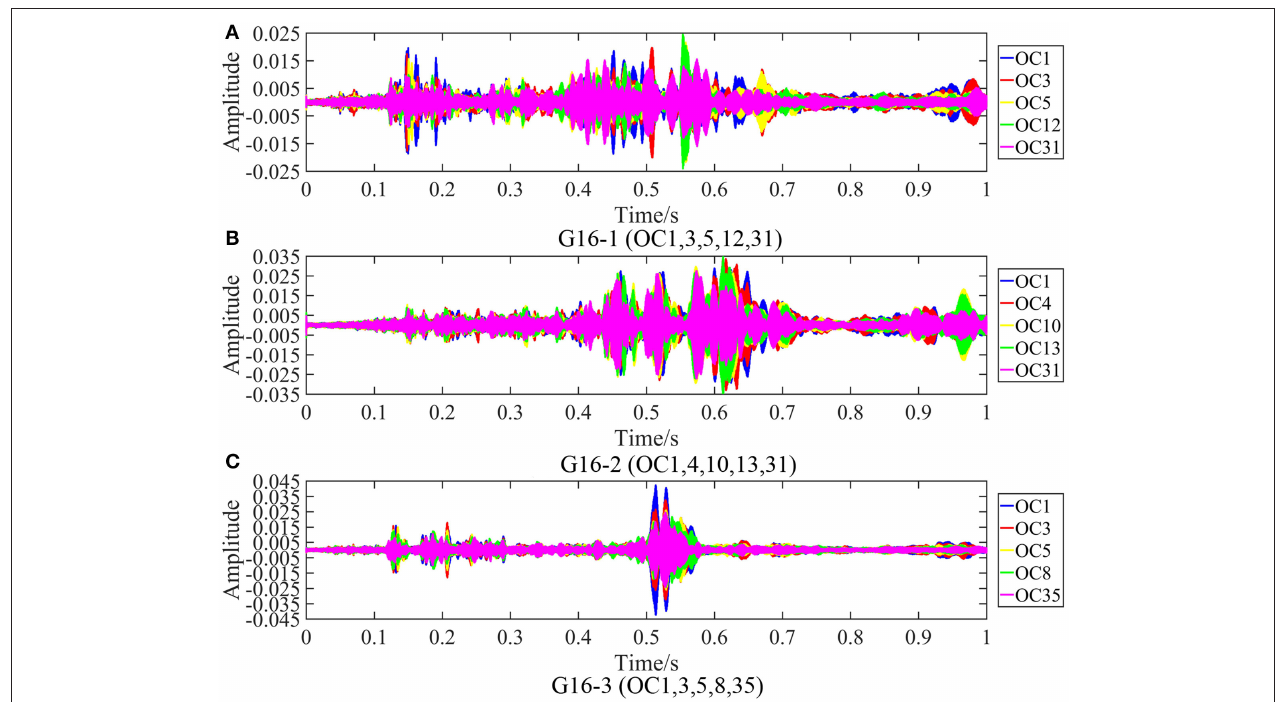
FIGURE 7 | Time domain of G16 after testing under different operating conditions. (A) Time domain of G16-1 under different operating conditions. (B) Time domain of G16-2 under different operating conditions. (C) Time domain of G16-3 under different operating conditions.